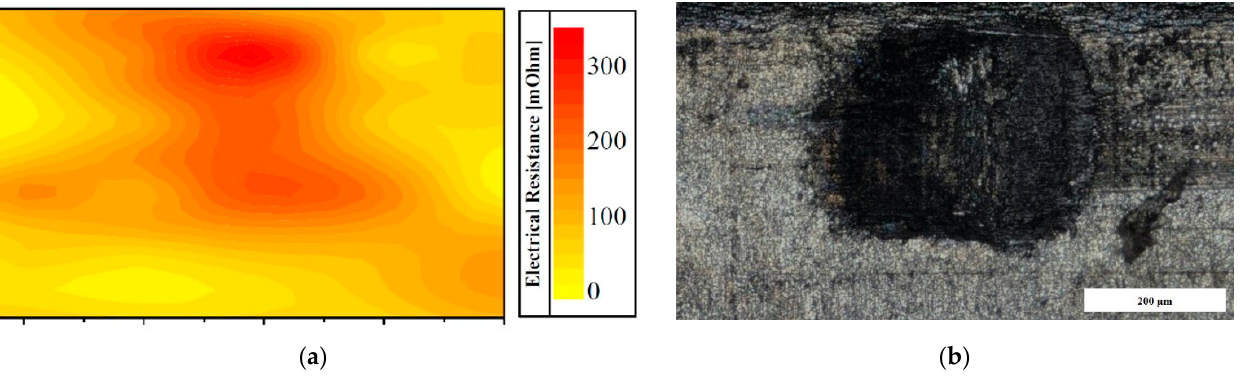
Figure 8. Contact resistance mapping and optical image of an electrical connectors stressed by a vibration and temperature cycle test (contact force 0,7 N; current 10 mA; limit of voltage 10 V): ( a ) Distribution of the electrical contact resistance; ( b ) Optical image of the contact area.